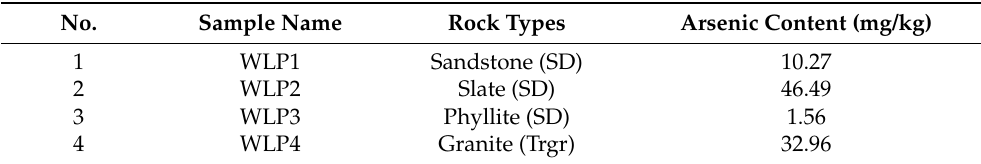
Table 2. Arsenic content in rock samples.